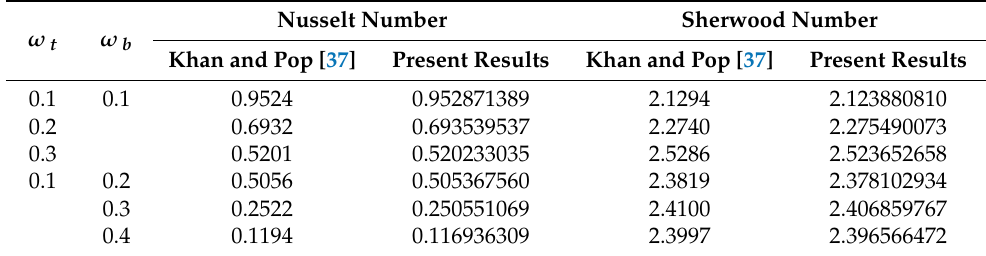
Table 3. Numerical comparison with the previous results (absence of nanoparticles) and the present results (considering φ 1 = φ 2 = β = λ =